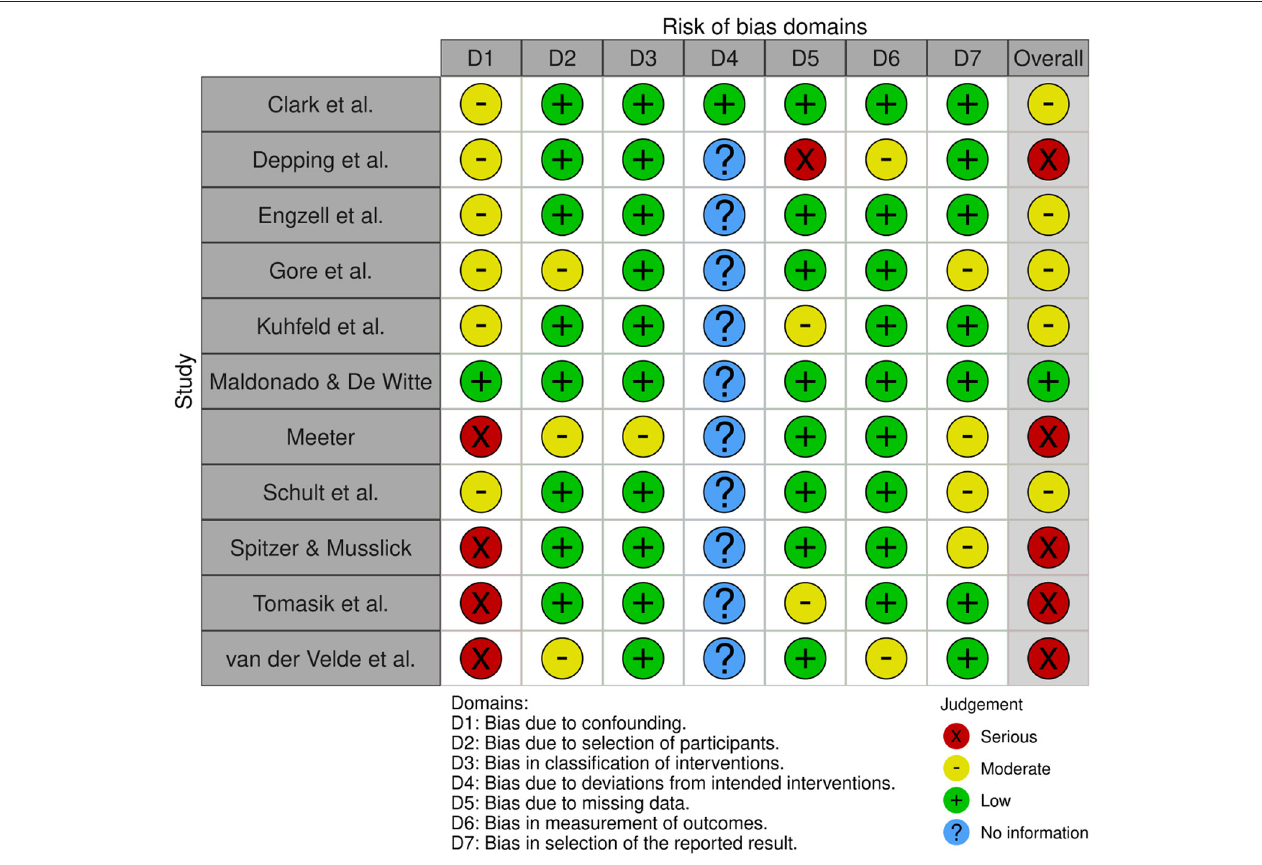
FIGURE 2 | Result of the cochrane risk of bias